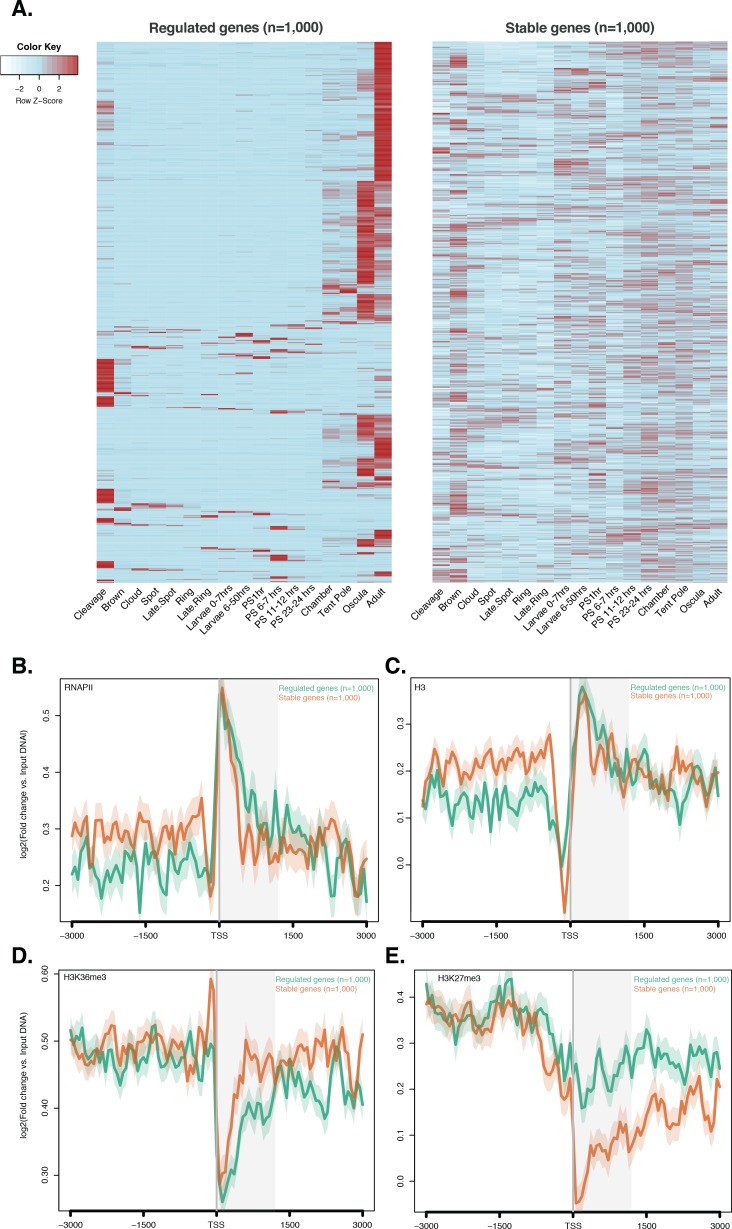
ChIP-seq profiles of RNAPII, total histone H3, H3K36me3 and H3K27me3 across regulated and stable genes.(A) Developmental expression profile, from early cleavage to adult, of the regulated and stable protein-coding genes (see main text and Materials and methods for details). Expression levels were measured by CEL-seq and rescaled by row. Red indicates high expression level, light blue low expression. Note that the ‘regulated’ genes show much more restricted expression patterns, being typically expressed at only one or two stage(s) of development (oscula and/or adult), than both ‘stable’ and ‘high-variance’ genes (see Figure 2—figure supplement 4A for a comparison). PS, post-settlement postlarva. (B) TSS-centred average input DNA normalised read coverage plot of RNAPII, (C) total H3, (D) H3K36me3 and (E) H3K27me3 across ‘regulated’ and ‘stable’ protein-coding genes during Amphimedon development. The x-axis spans ± 3 kb around TSSs and represents the position within the gene relative to TSS. The y-axis represents the input DNA normalised enrichment for ChIP-seq reads in adult. Light blue line: first 1,000 regulated genes. Orange line: first 1,000 stable genes. The shaded gray area represents the average size of Amphimedon coding sequences.